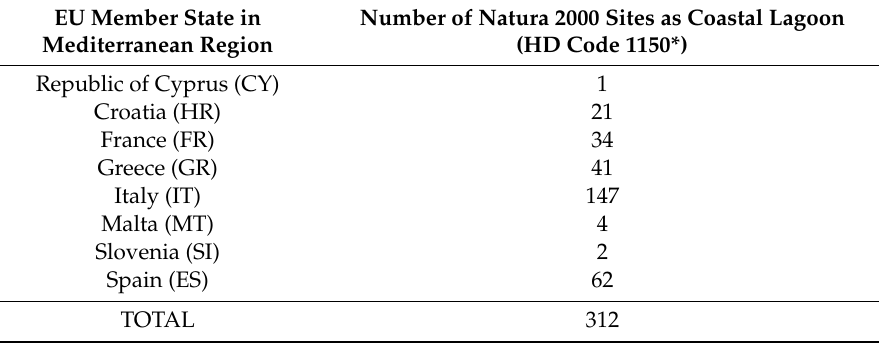
Table 1. Number of “Coastal lagoons” (habitat code 1150*) in the Natura 2000 Network for EU Member States in the Mediterranean biogeographic region (Portugal excluded). Data were elaborated by consulting [3].